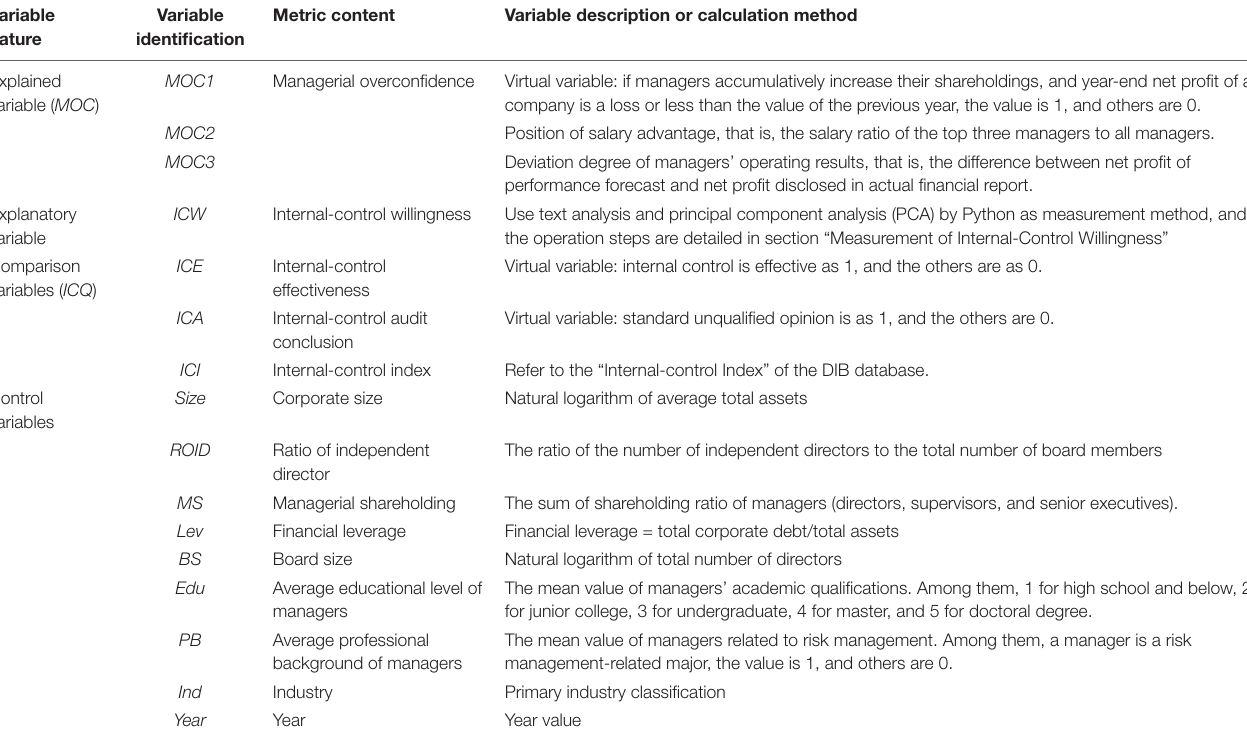
TABLE 1 | Variables of test models. Variable nature